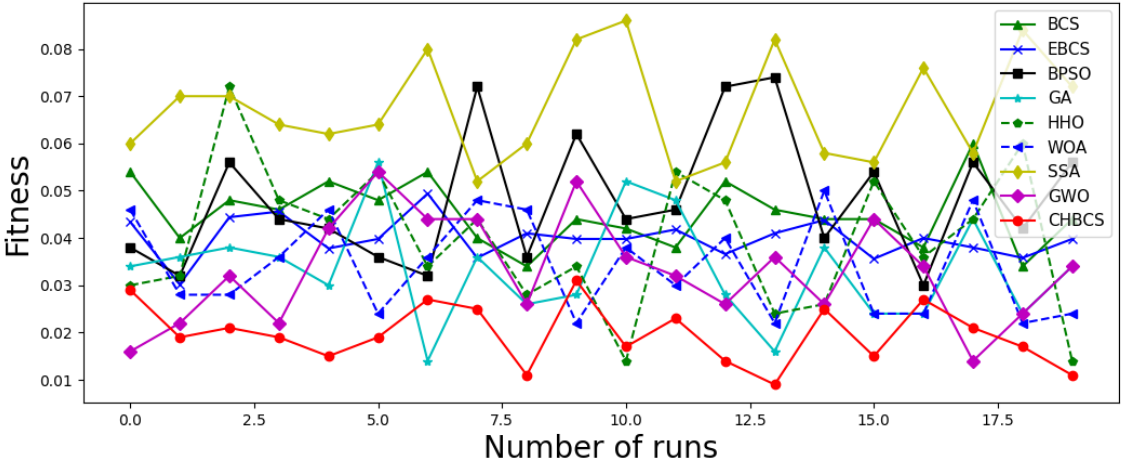
Figure 13. The optimal fitness value of nine algorithms after being run 20 times.